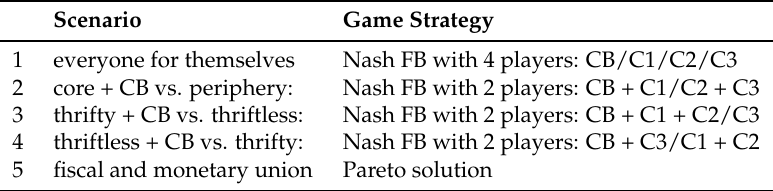
Table 6. Different coalition strategies.